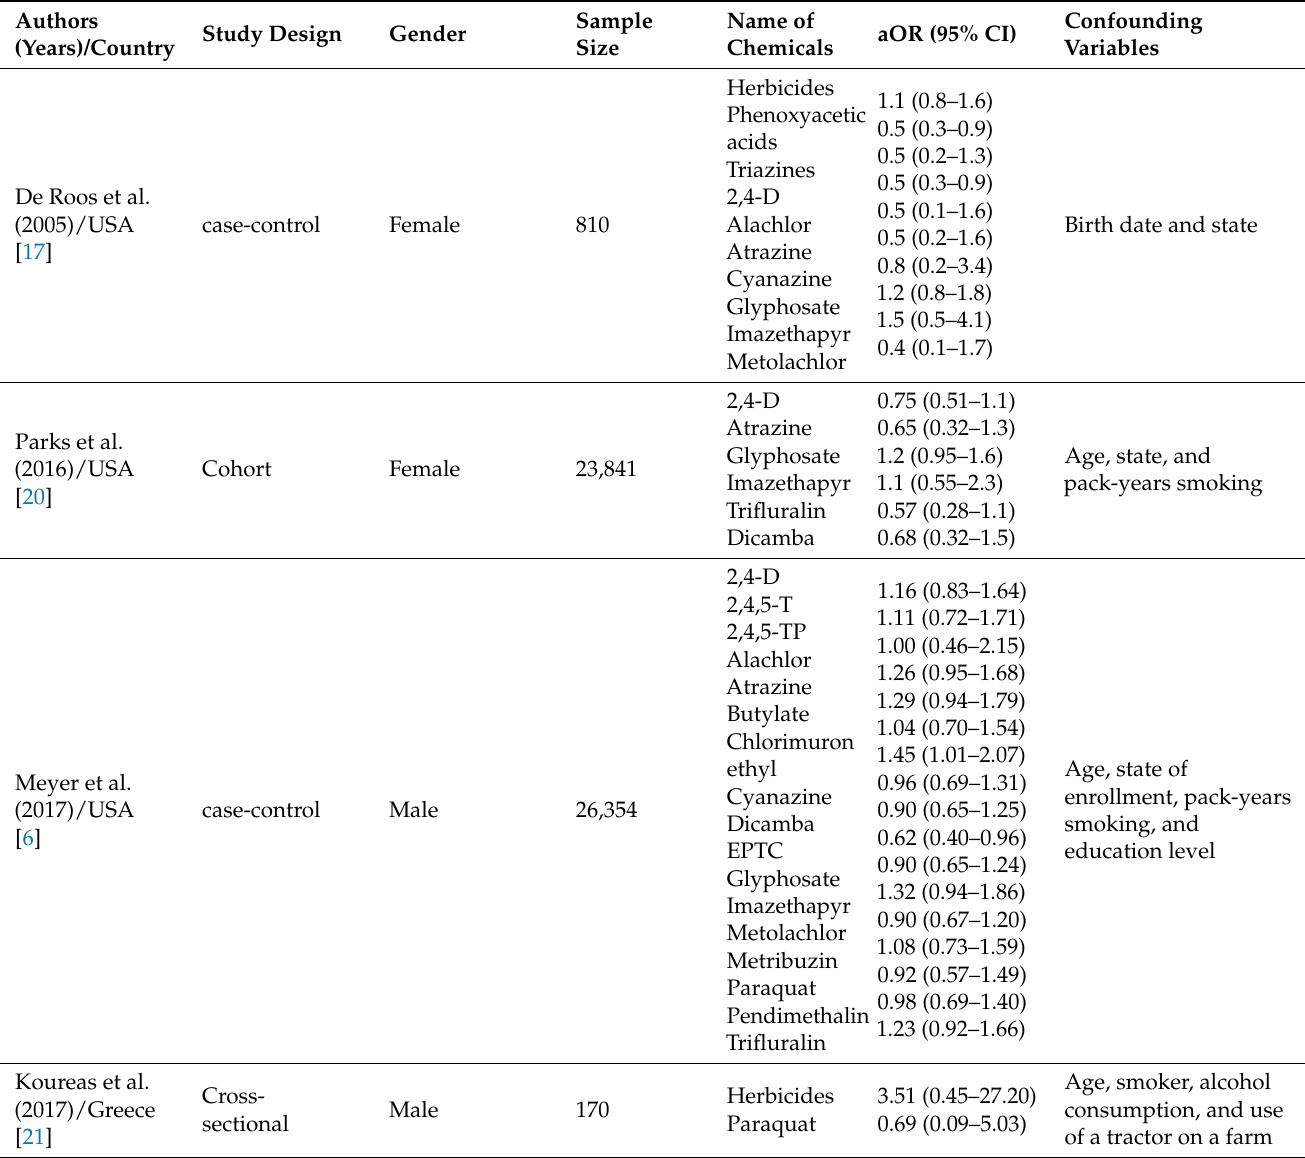
Table 2. The association between exposure to herbicides and RA